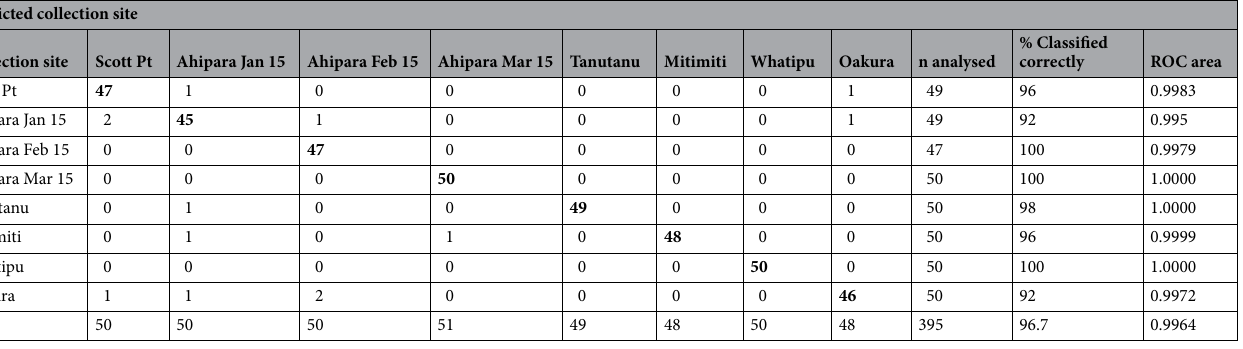
Table 4. Classification success of a quadratic discriminant function analysis (Q-DFA) model run on elemental ratios in the shells of juvenile green-lipped mussels ( P. canaliculus ) collected in January 2015 from six sites along the west coast of the North Island of New Zealand. Additional mussels were collected from Ahipara in February and March 2015. Sites listed from north to south. Numbers in bold, on the diagonal, indicate the number of mussels from a collection site that were correctly classified as being from that site (the predicted collection site).